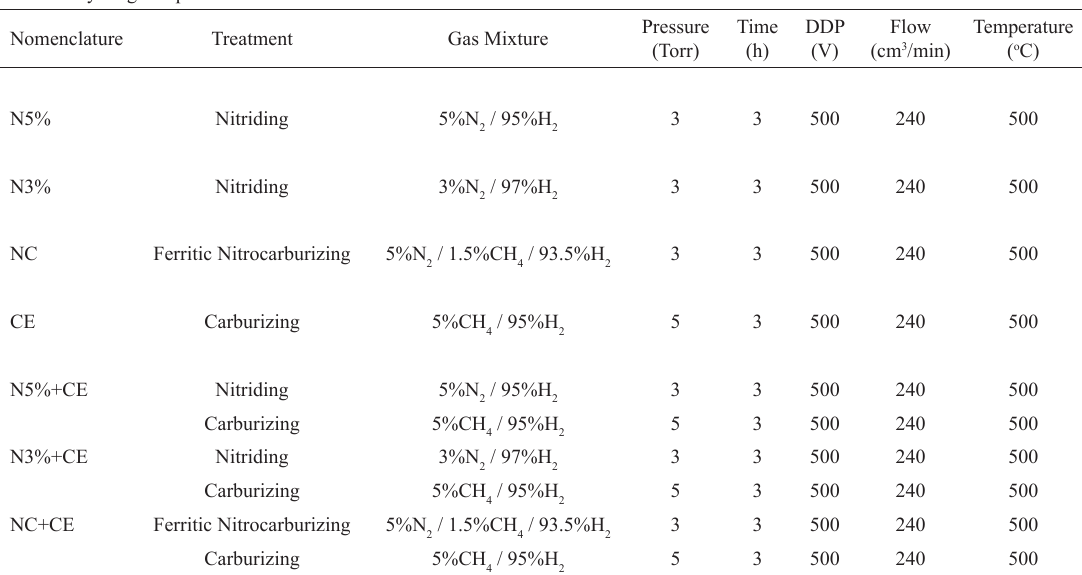
Table 2: Cycling and parameters of the